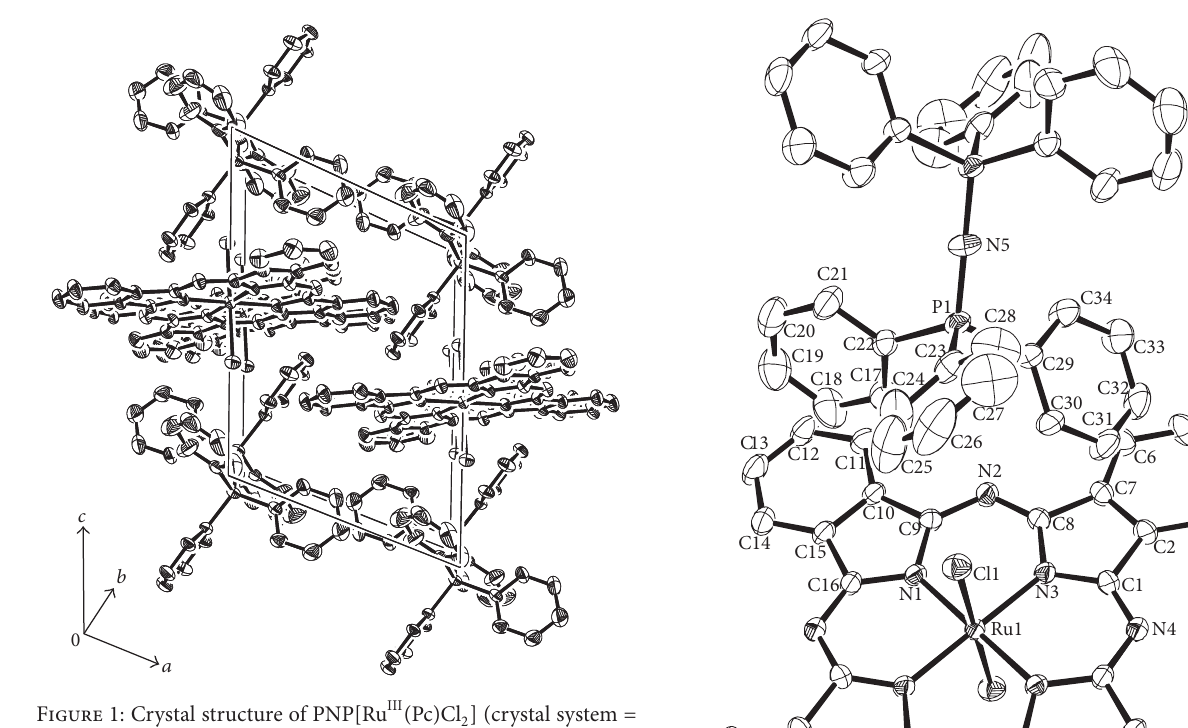
F 1: Crystal structure of PNP[Ru III (Pc)Cl triclinic; Z = 1).